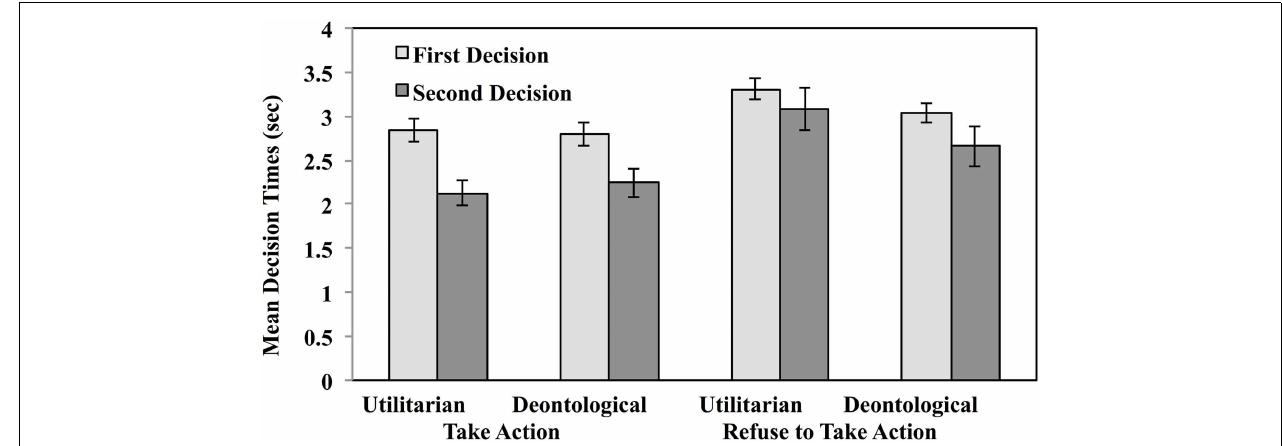
FIGURE 7 | Mean decision times for utilitarian and deontological judgments as a function of question type in Experiment 2. First decisions were made within a time constraint of 6s. Second decisions were made without time constraints.